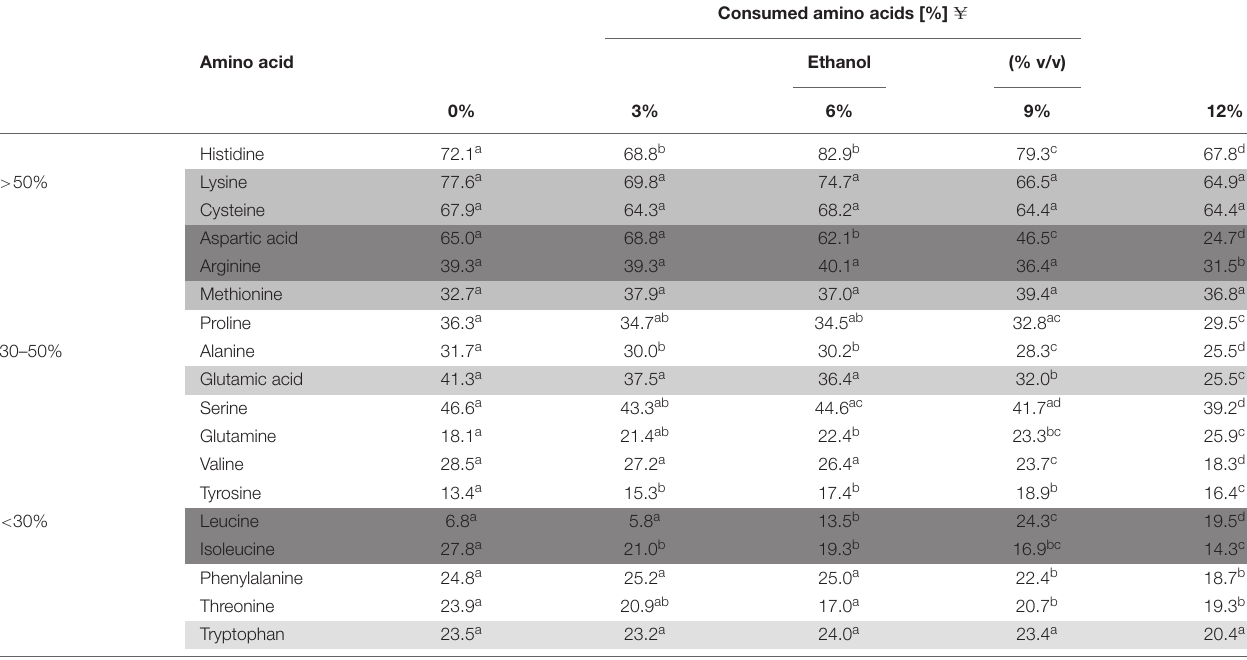
Consumed amino acids [%]